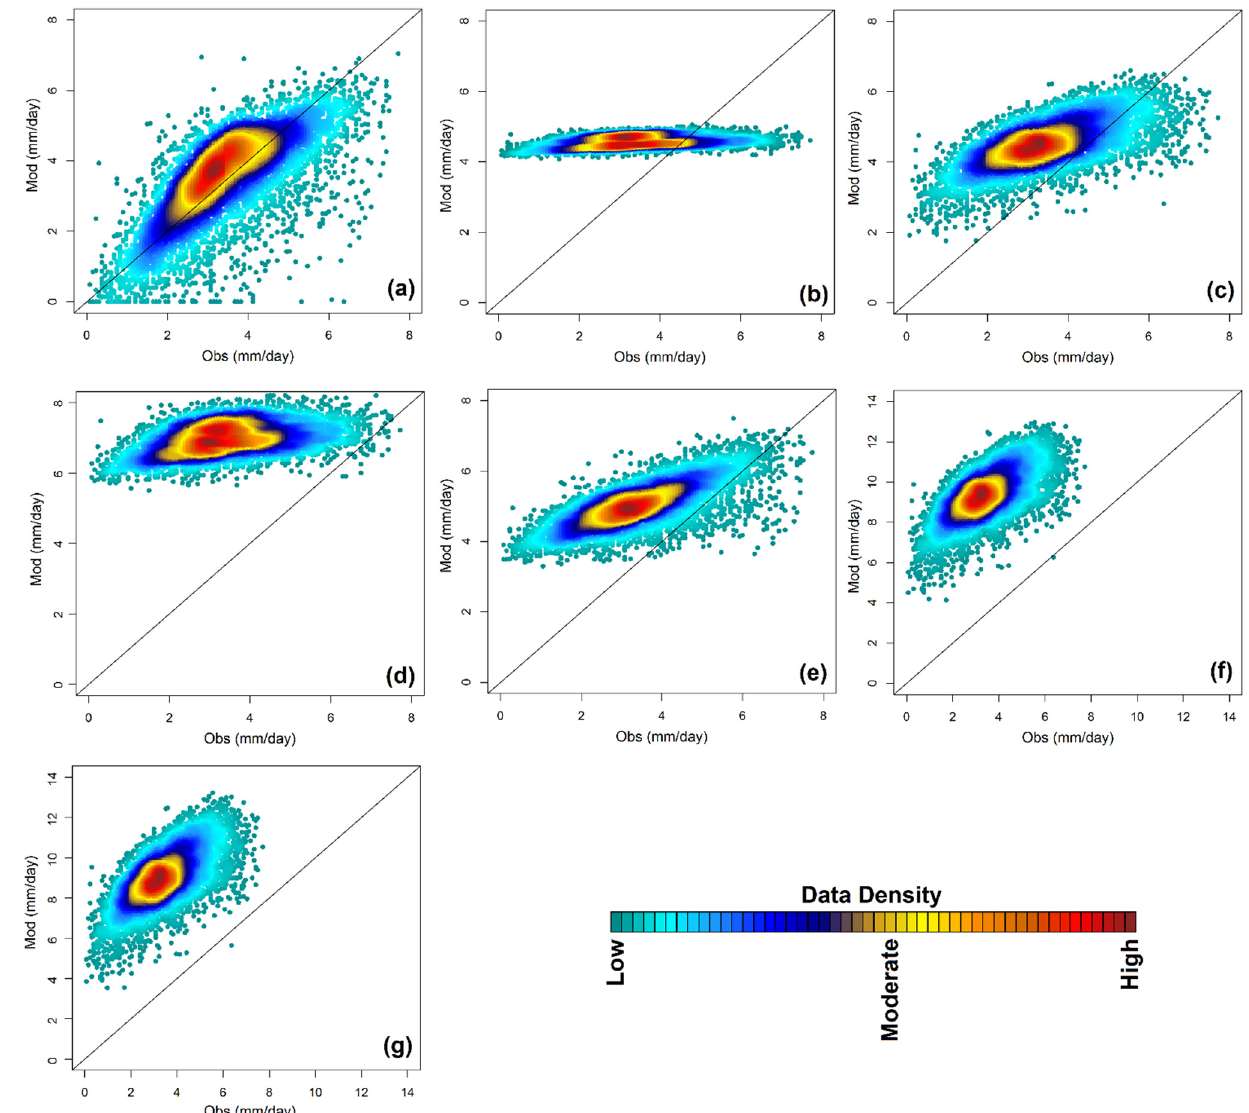
Figure 4. Density scatter plots showing the relative performance of the GEP ( a ) ET model compared to ( b ) FAO Blaney-Criddle, ( c ) Linacre, ( d ) Kharrufa, ( e ) Hargreaves and Samani, ( f ) Trajkovic, and ( g ) Ravazzani ET models.